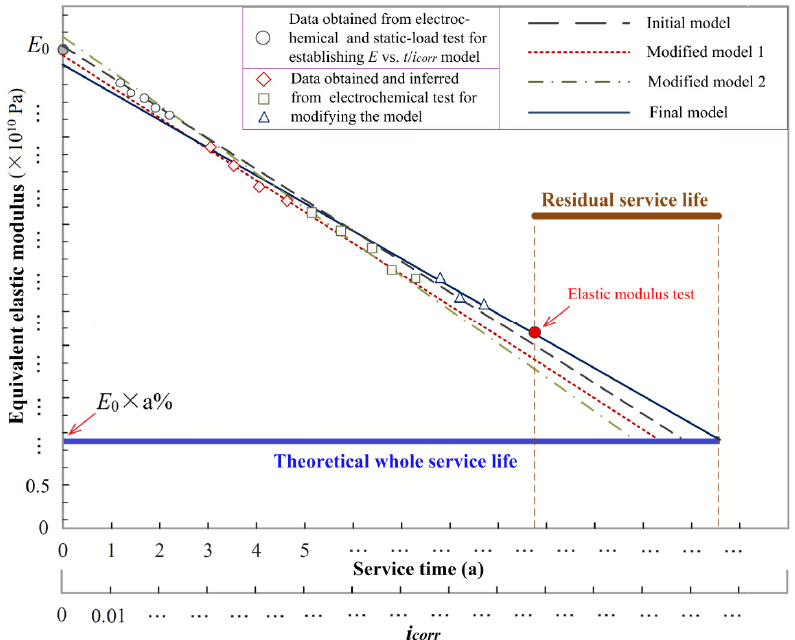
Figure 12. Prediction for RC bridge’s residual service life.